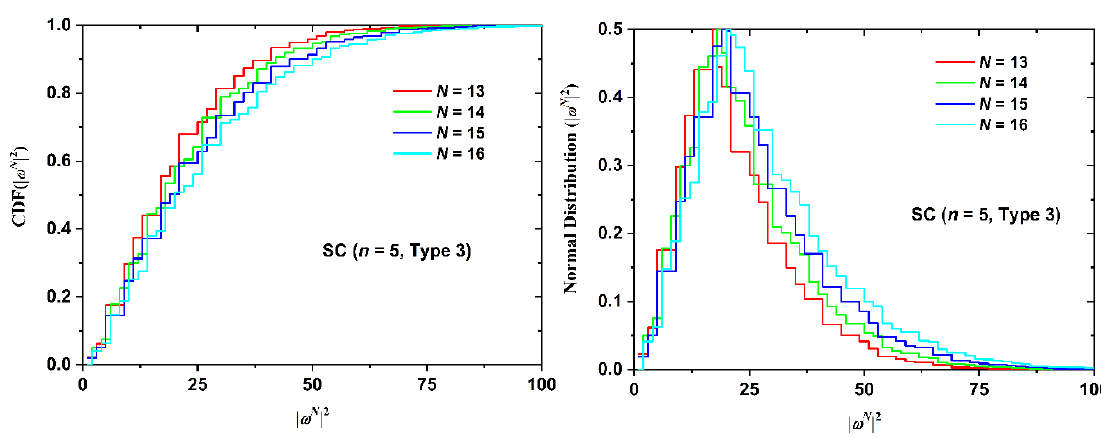
Figure 15. (Left Panel) Cumulative distribution function (CDF) and (Right Panel) the folded variant of the square end-to-end distance for the SC restricted lattice for SAWs of fixed number of confined layers ( n = 5) and point of origin (Type 3). Different curves correspond to different number of SAW steps, N.